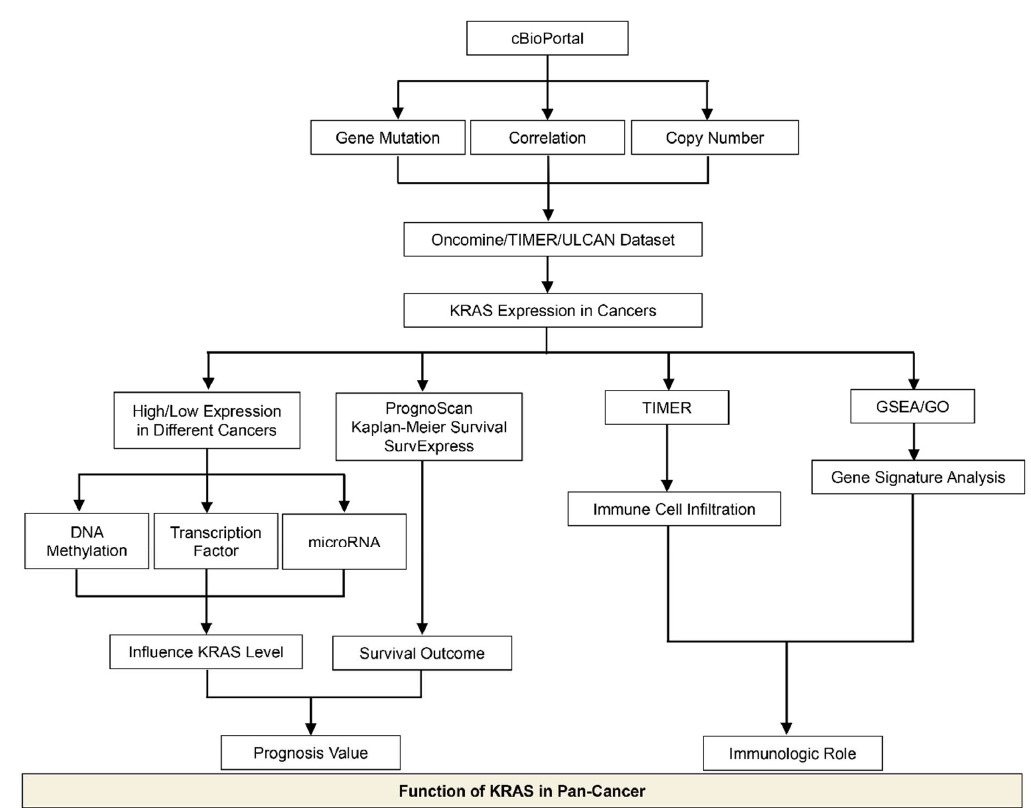
Figure 12. Schematic depicting the model of this